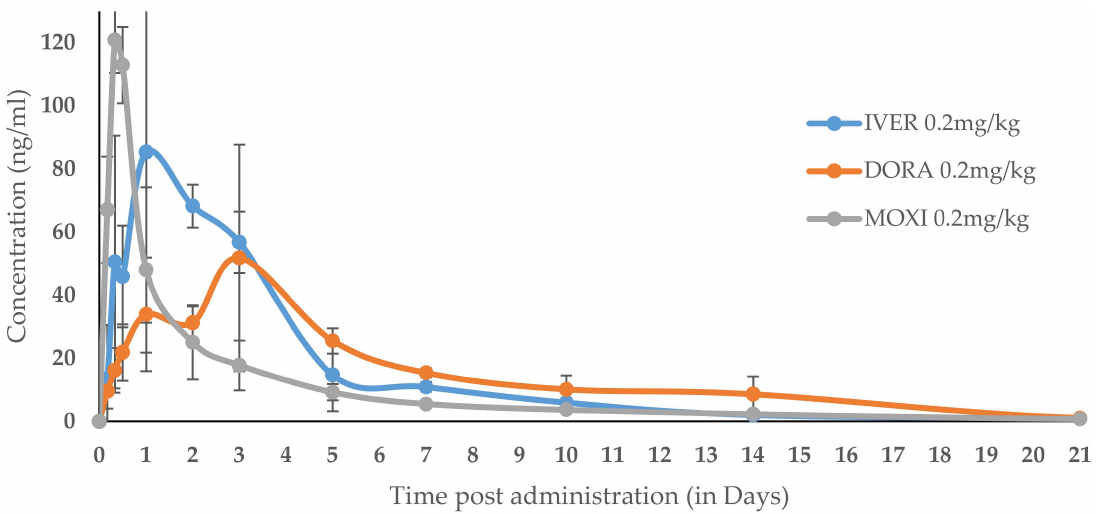
Figure 5. Plasma concentration versus time curves of IVER, DORA, and MOXI in bovine plasma after the subcutaneous administration of Ethiopian zebu cattle bovines ( n = 3) with a single dose of 0.2 mg/kg